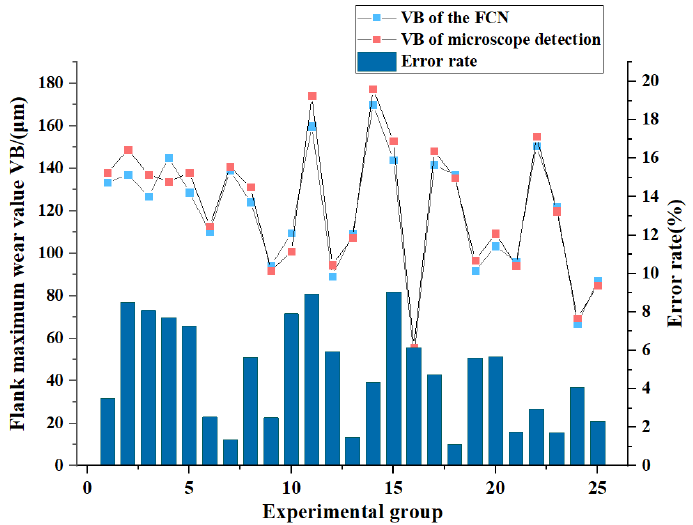
Figure 14. Comparison of the maximum wear values measured by the two methods.